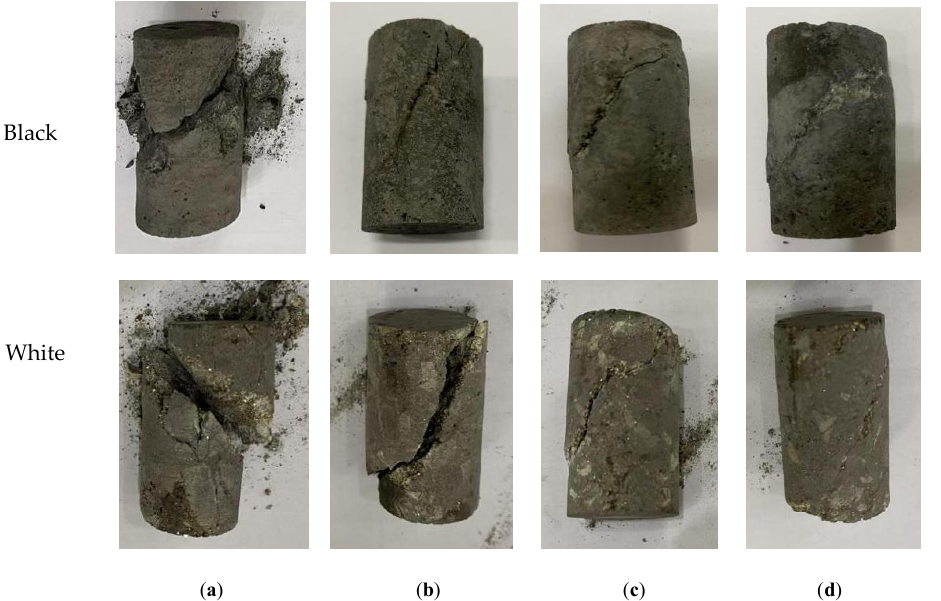
Figure 15. Failure pattern images of SMS specimens under different confining pressure: ( a ) 2 MPa; ( b ) 5 MPa; ( c ) 8 MPa; ( d ) 10 MPa.